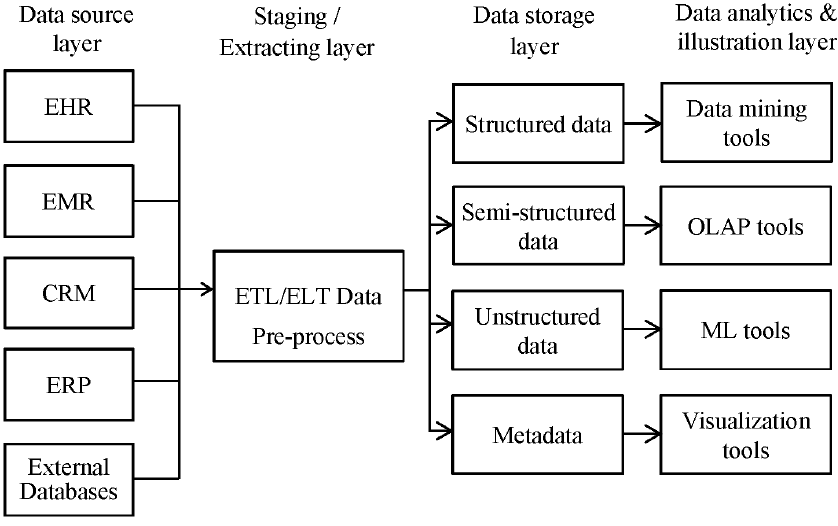
Figure 1. The architecture of a typical e-health data warehouse, modified based on [6].